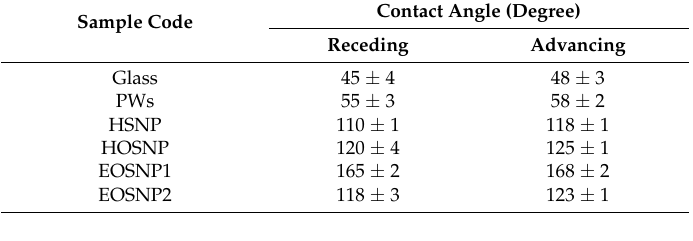
Table 3. Contact angle of the water droplet on the hydrophobic SNP microcapsule films, at 25 °C.